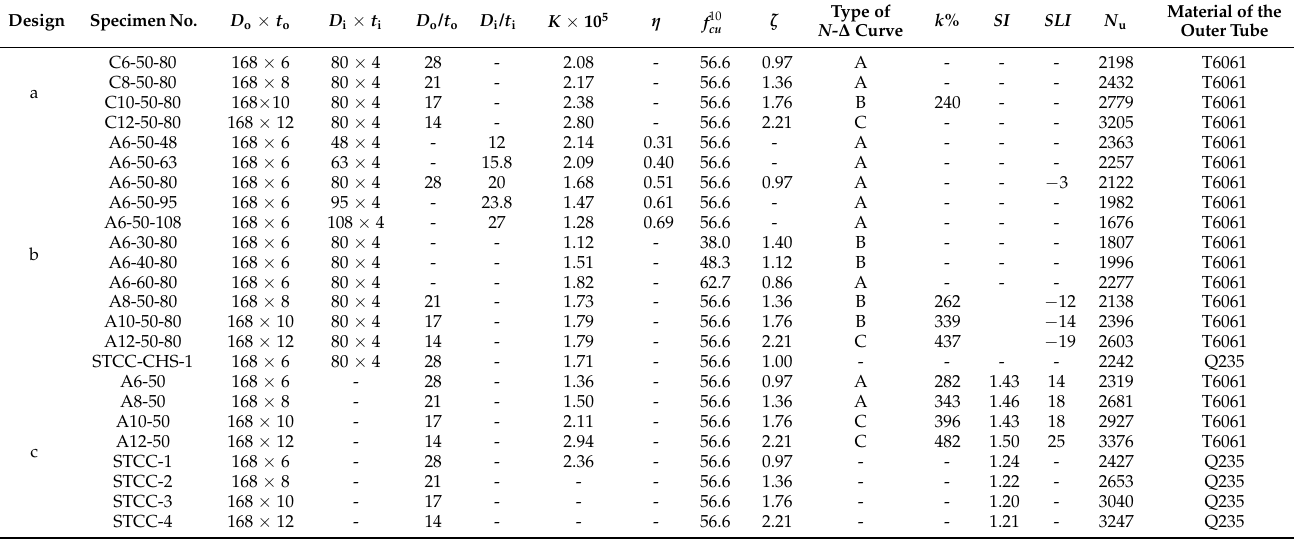
Table 1. Basic parameters of the specimen.